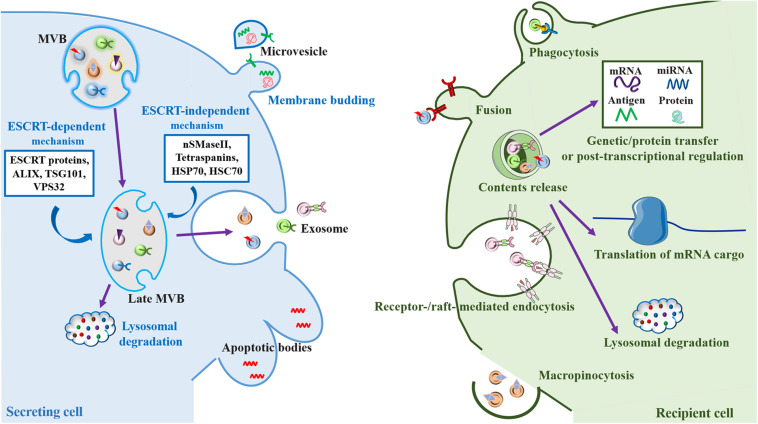
Biogenesis and cell-to-cell communication of extracellular vesicles (EV), especially exosomes. Exosomes are formed by the inward budding of the multivesicular body (MVB) membrane, which is formed by invagination of the endosomal membrane. Early endosomes go through transition to late endosomes and are further burdened to form late MVBs containing intraluminal vesicles (ILVs) (Colombo et al., 2014). Cargo sorting into exosomes involves the endosomal sorting complex required for transport (ESCRT)-dependent mechanism, which are managed by ESCRT proteins (ESCRT-0, I, II, and III) and their accessories (ALIX, TSG101, and VPS32) (Hurley, 2010; van Niel et al., 2018), and ESCRT-independent mechanism, which are mediated by neutral sphingomyelinase 2 (nSMaseII), tetraspanins, and the chaperone heat shock proteins (HSP70 and HSC70), can develop ILVs (Malla et al., 2018). ILVs have two fates, either fusing with the lysosome resulting in the degradation of the ILVs and their contents for recycling as an endolysosomal pathway (Klumperman and Raposo, 2014), or fusing with the plasma membrane where they are released into the extracellular space as exosomes through a secretory pathway (Heijnen et al., 1999). Microvesicles are formed directly by outward budding of the plasma membrane, a course which is managed by the ESCRT components and ADP ribosylation factor 6 (ARF6), some small GTPases, lipids, and Ca2+-dependent enzymatic machineries (Thompson et al., 2016). Apoptotic bodies are the largest of the EVs. They “bleb” off the cell membrane and contain material from cells undergoing apoptosis, which are typically engulfed by macrophages (Thompson et al., 2016). After release into the extracellular space, exosomes can be internalized by recipient cells mediated by the interaction of various exosomal surface proteins and cellular receptors via several mechanisms including phagocytosis, plasma membrane fusion, macropinocytosis and endocytosis (McKelvey et al., 2015). The contents of exosomes can effectively influence cellular processes through taking part in genetic/protein transfer, transcriptional regulation or post-transcriptional regulation. Alternatively, exosomes can be further fused with the lysosomes for degradation (Saeedi et al., 2019; You and Ikezu, 2019).